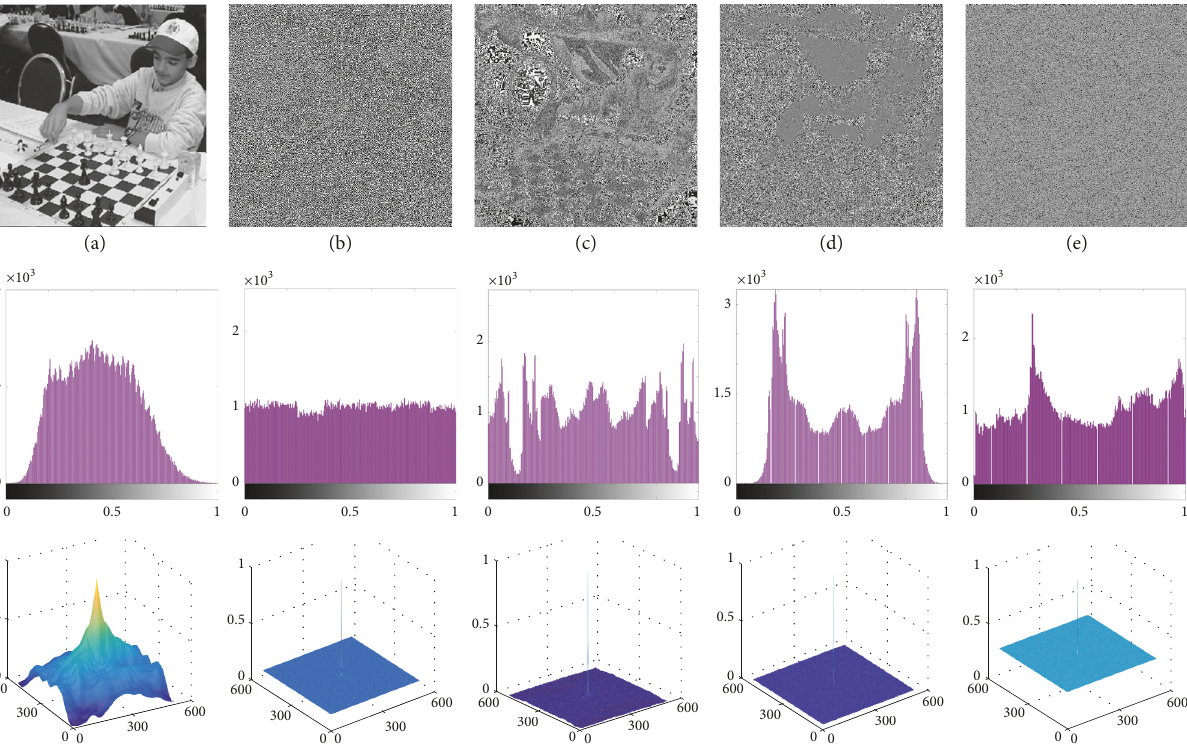
Figure 5: Comparative experiment of “Chess”: (a) original image, (b) 2D-SLMM, (c) SBE-LBP, (d) BPE-XOR, and (e) method of using 2D- SLMM to modulate original image. The second row shows their corresponding histograms and the third row shows their corresponding autocorrelation